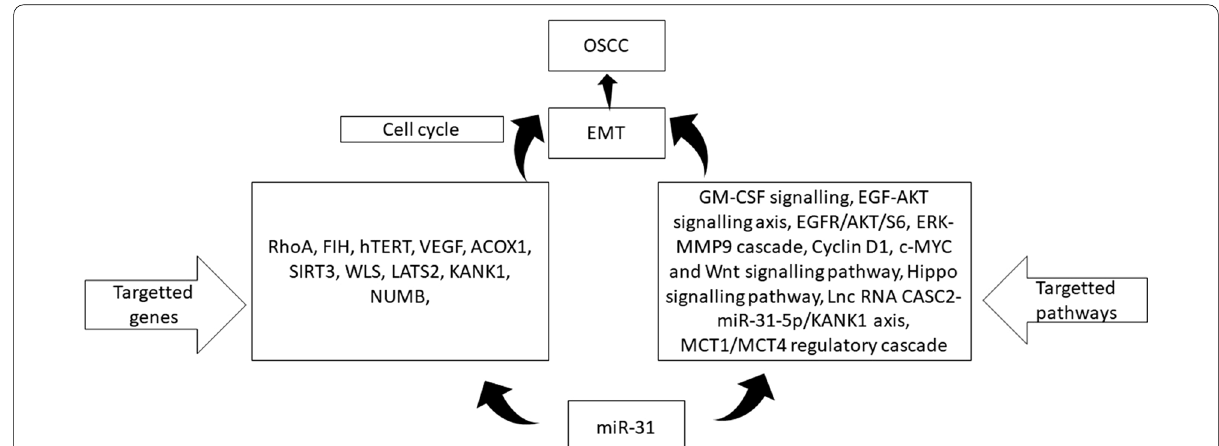
Fig. 3 Development of OSCC by upregulation of miR31. The figure depicts the possible genes and pathways involved in the development of OSCC when miR31 is